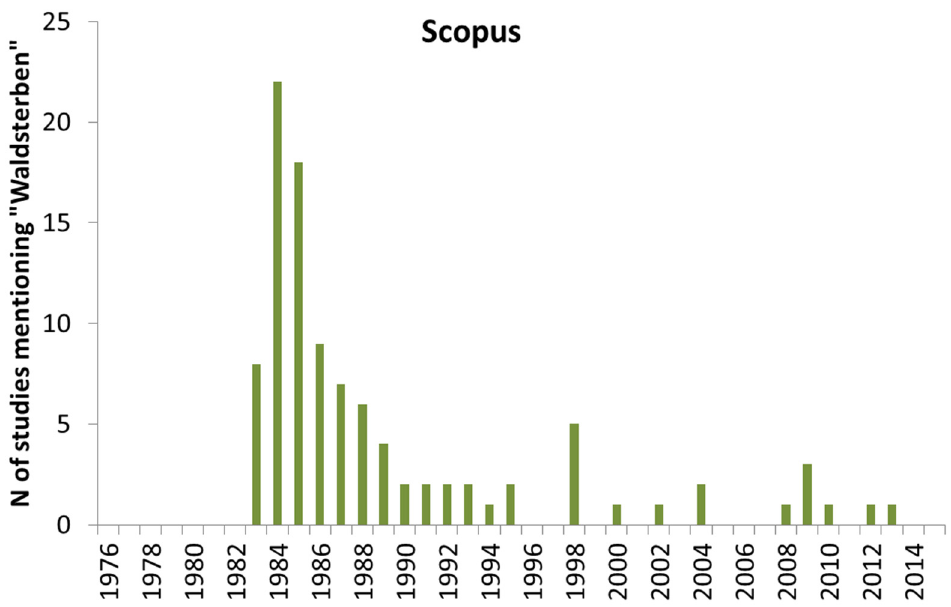
Figure 2. Number of studies mentioning “Waldsterben” (German for “forest mortality”) in Scopus, as of September 2015. Total number = 101.